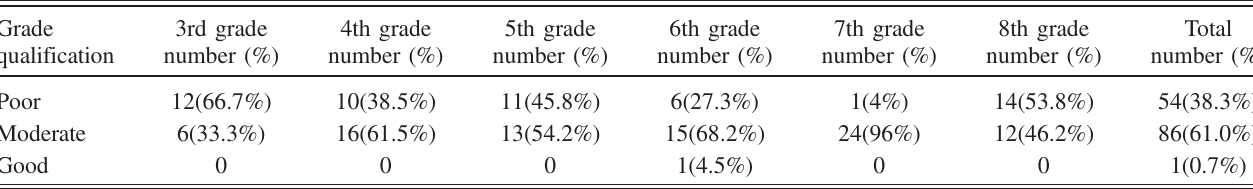
TABLE I. Qualifications of the analogies used in science textbooks (from 3rd to 8th grades) due to the elements in Glynn ’ s TWA approach. Poor analogy means none of the TWA elements existed; moderate analogy means one or two elements of TWA existed, and good analogy means all three elements of TWA